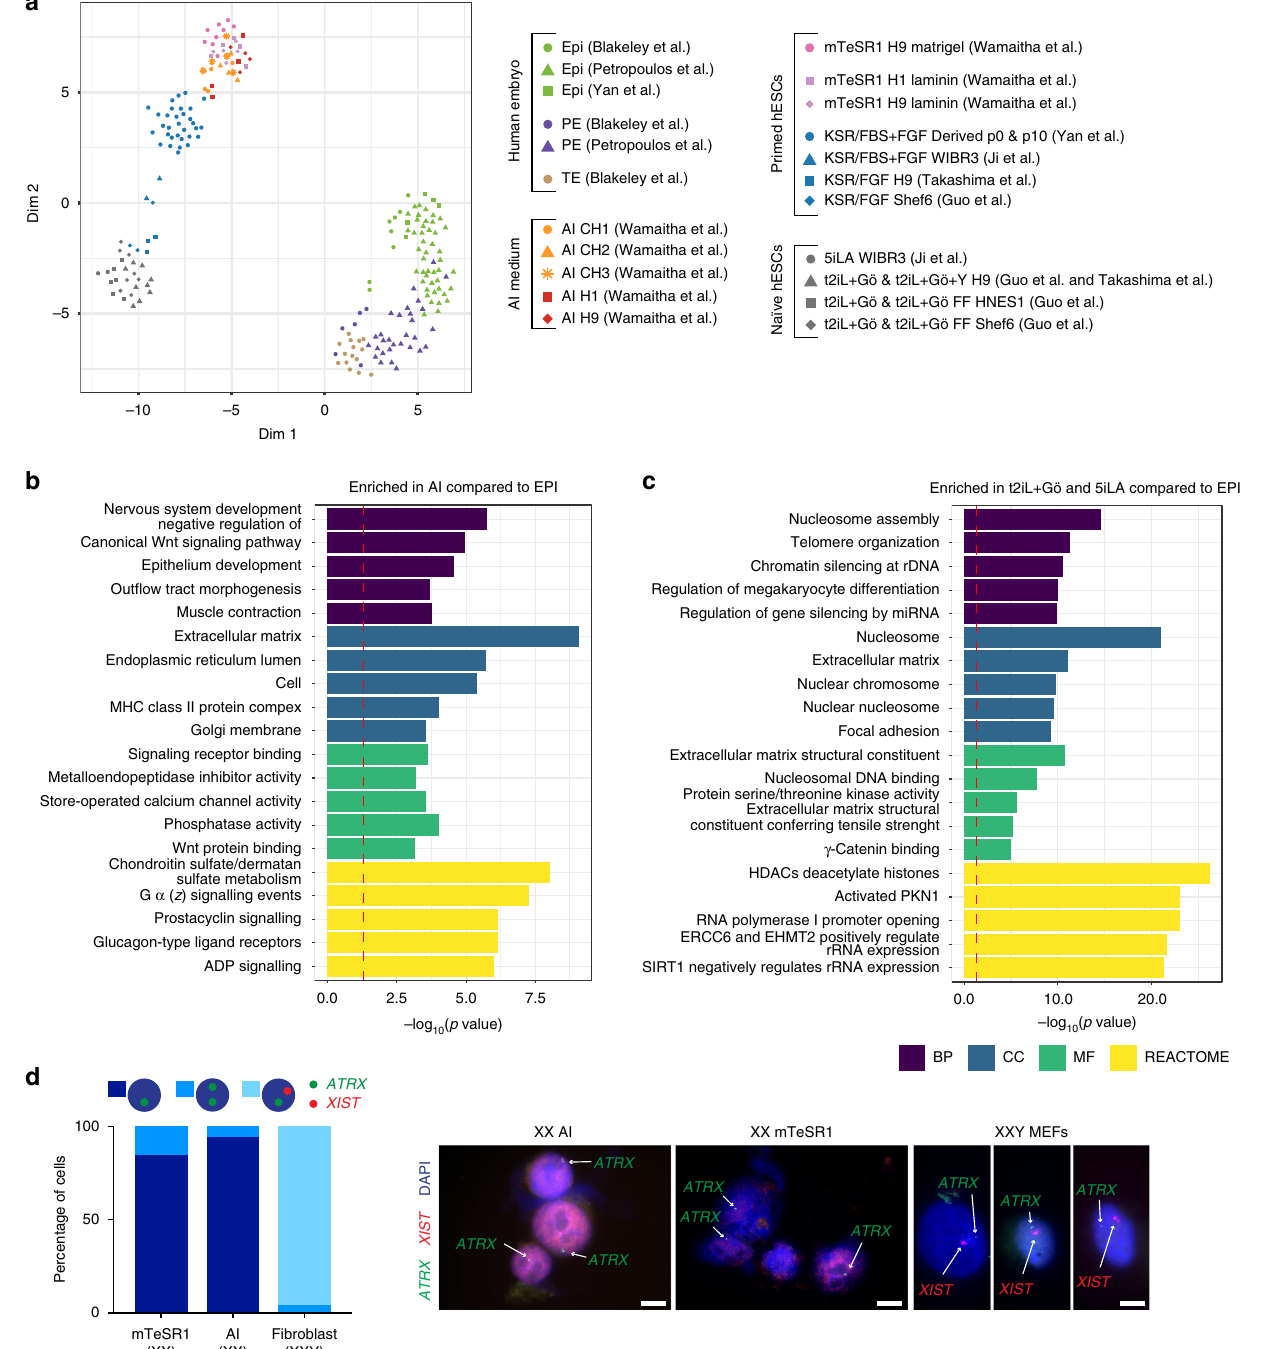
Fig. 2 hESCs cultured in AI medium are transcriptionally similar to conventional hESCs. a Clusters detected after applying the unsupervised clustering tool griph to single-cell RNA-seq data from EPI, PE or TE cells of the human blastocyst 10,37,56 and hESCs cultured in AI, mTeSR1, KSR + FGF, 5iLA or t2iL + Gö media 28,33,37,58 . A colour-coded sample key is provided. b , c Comparison of embryonic EPI cells to cells cultured in AI medium or naïve (5iLA or t2iL + Gö) media. The most enriched GO terms for genes associated with biological process (BP), cellular component (CC), molecular function (MF), and REACTOME pathways associated with differentially expressed genes are shown based on Benjamini-Hochberg corrected p-values. Red-dashed lines correspond to the signi fi cance level α = 0.05. d Quanti fi cation of RNA FISH in XXY fi broblast cells or in H9 XX hESC lines cultured in mTeSR1 or AI media for the transcription foci of XIST and ATRX , which is normally subject to X-chromosome inactivation. n = 51 mTeSR1 hESCs, 50 AI hESCs and 51 fi broblasts. Representative DAPI and RNA FISH images of hESCs or fi broblasts are shown. Scale bar: 10 μ m. Source data are provided as a Source Data fi